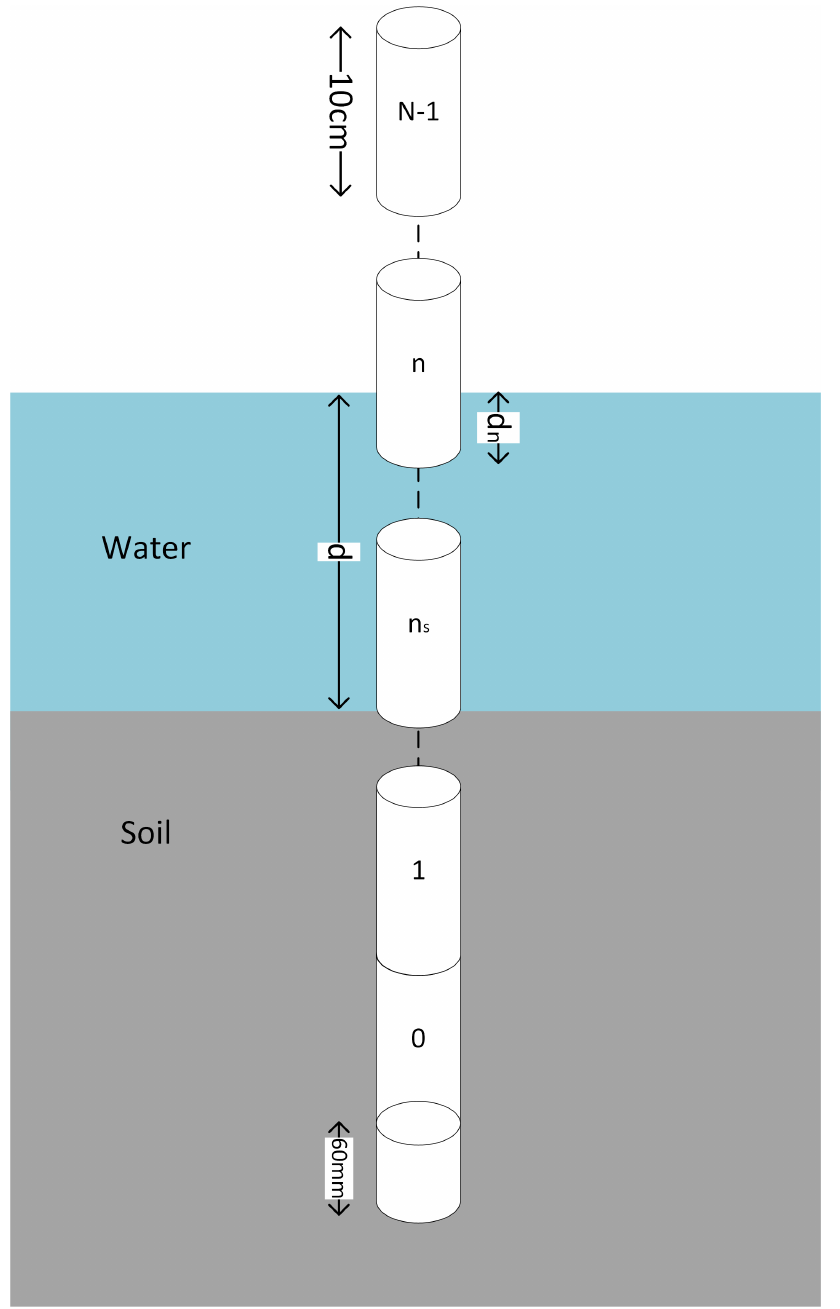
Figure 1. Diagram of a multiple-sensor capacitive soil moisture probe. The probe contains N − 1 sensors, d is the total water depth in mm, d n is the water depth relative to the bottom of the n -th sensor and n s is the sensor sitting above soil level. Each of the sensors returns volumetric water content (VWC) (%), temperature ( o C) and conductivity (dS/m)